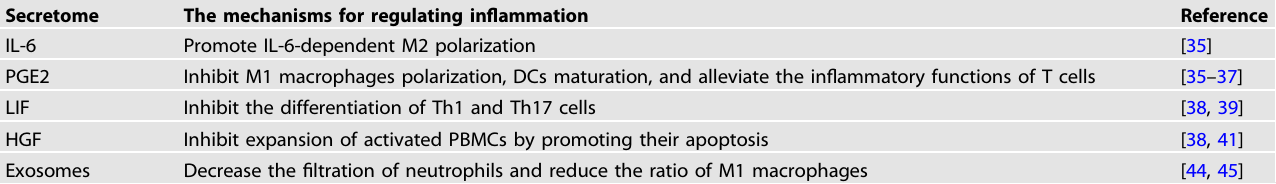
Table 1. Paracrine effectors of MSCs in the regulation of in fl